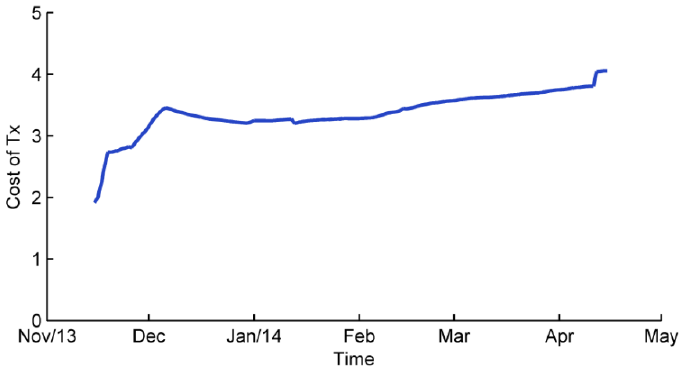
Figure 10. Network-level cost of transmissions during the CTP evaluation period.